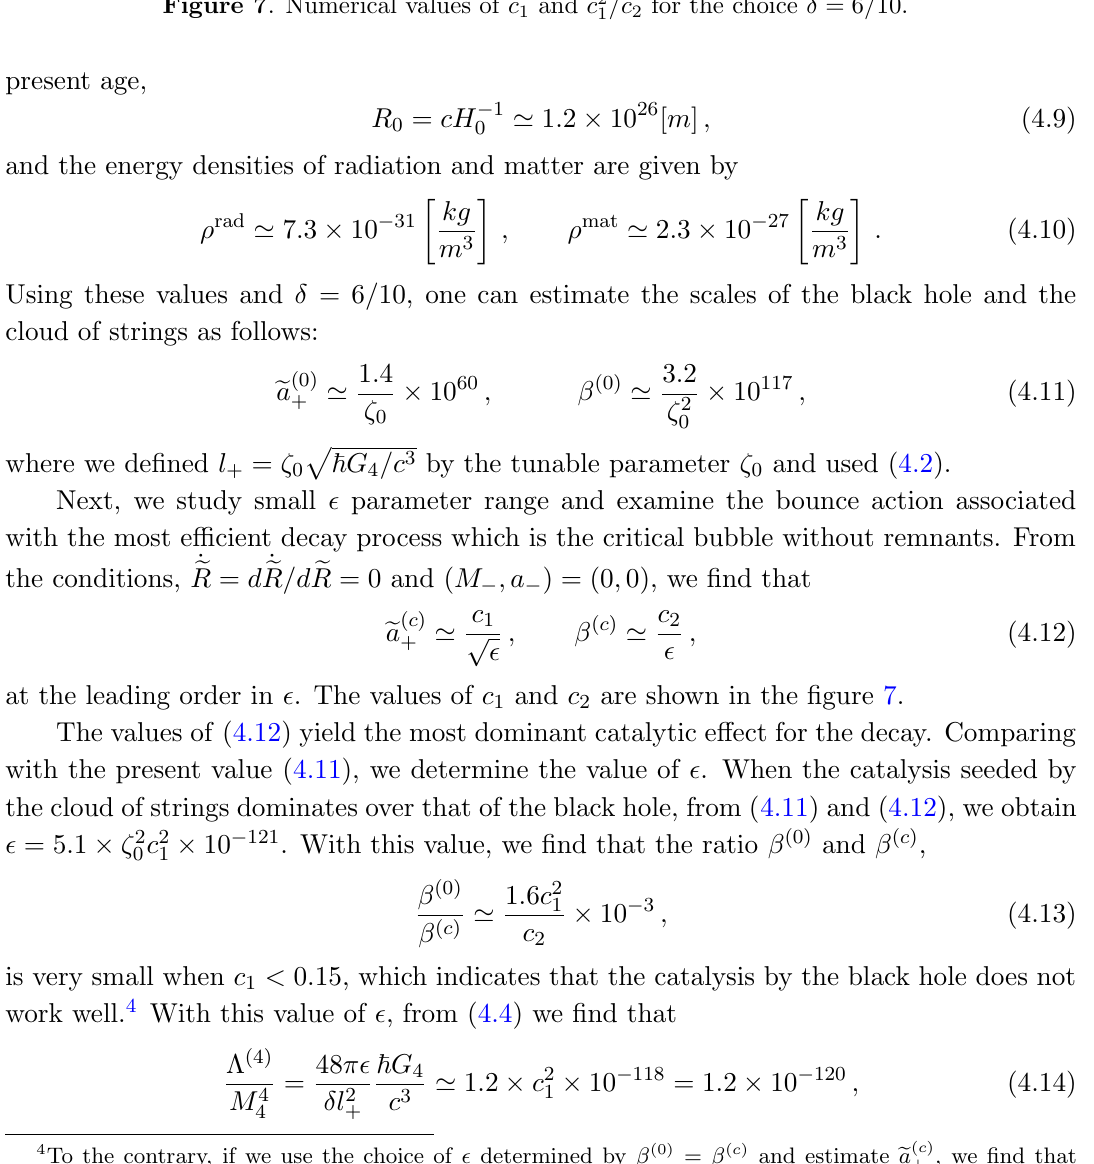
Figure 7 . Numerical values of c 1 and c 2